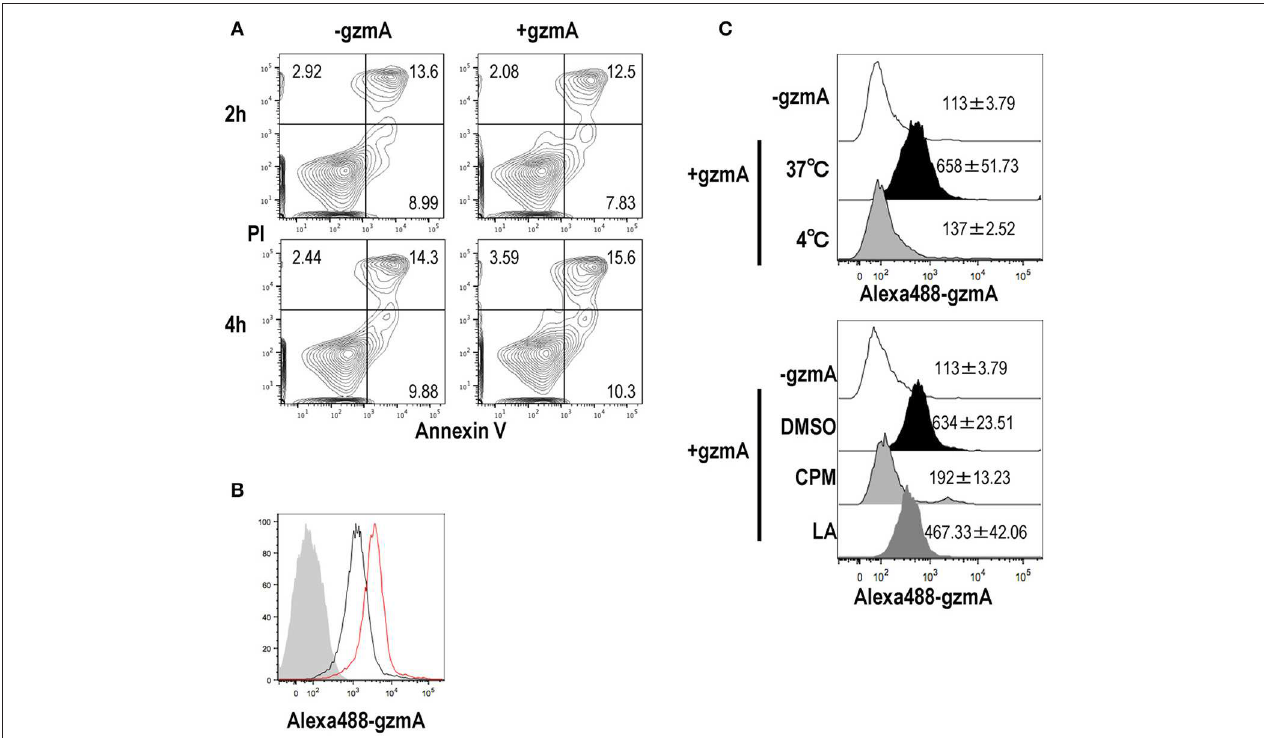
FIGURE 2 | GzmA is endocytosed by pDCs but does not induce apoptosis. (A) Assessment of cell viability and apoptosis in response to GzmA. After FL-DCs were cultured in the presence of GzmA for 2 (upper) or 4 (lower) h, they were stained with Annexin-V and PI ( n = 3). (B) Uptake of GzmA by pDCs. Alexa488-labeled GzmA were added to FL-DC cultures. The uptake of GzmA by pDCs (CD11c dim B220 + ) was analyzed by flow cytometry: before (shaded), 2 (black), and 4 (red) h later ( n = 3). (C) Same as in (B) , but FL-DCs were cultured at 4 ◦ C or 37 ◦ C during pulsing with GzmA for 2h (upper). Endocytosed of GzmA by pDCs was assessed by FACS analysis. In other experiments (lower), pDCs were pre-treated with DMSO, Chloropromazine (CPM) (20 µ g/ml) and Latrunculin A (LA) (5 µ M) for 40min before adding Alexa488-GzmA. Then, endocytosed of GzmA by pDCs was assessed by FACS 2h later. Numerical data indicate the MFI of Alexa488-GzmA (mean ± SEM, n =